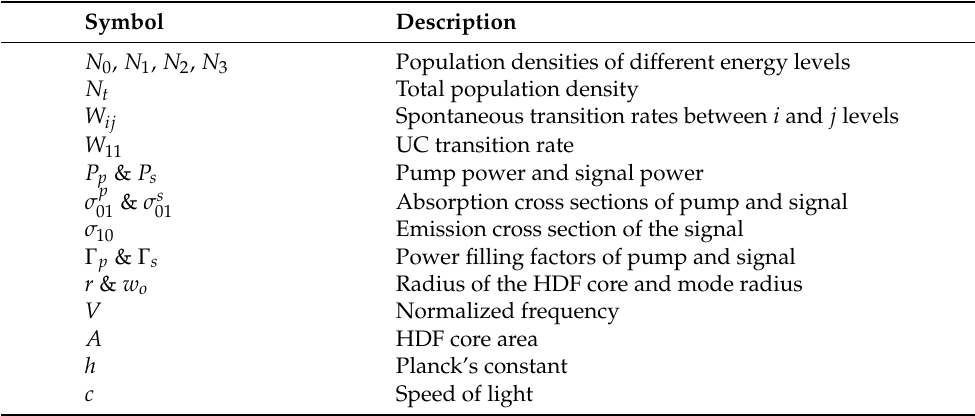
Table 1. Description of symbols used in Equations (1)–(10).